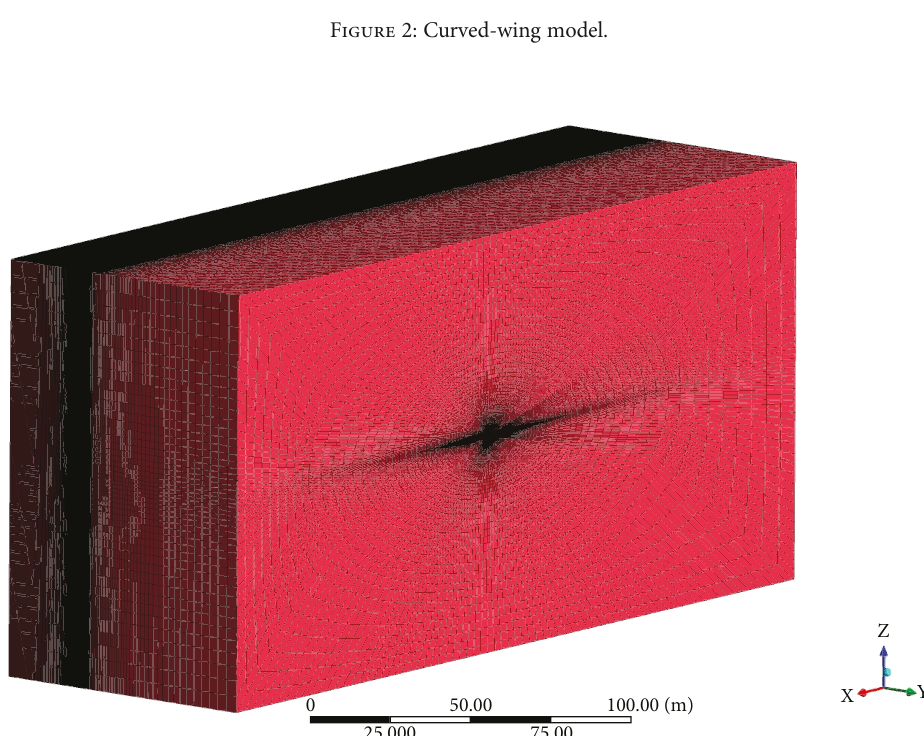
Figure 3: CFD mesh of fl uid domain (curved